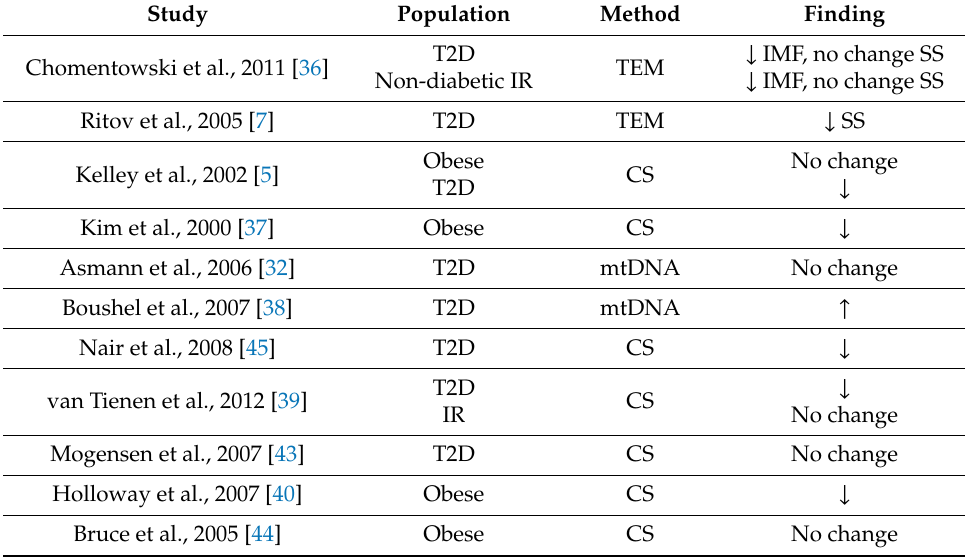
Table 1. Mitochondrial content in patients with obesity and / or type 2